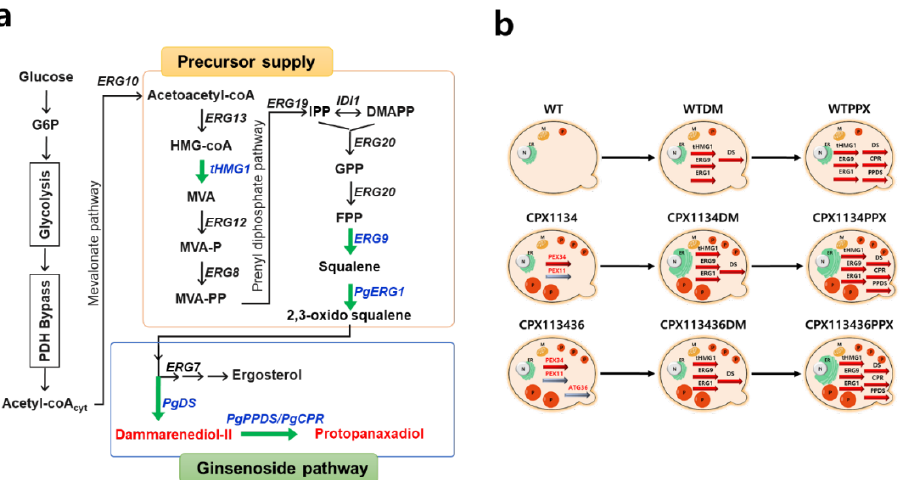
Figure 5. Production of dammarenediol II and protopanaxadiol via the mevalonate (MVA) pathway and schematic representation of the synthetic pathways in the engineered strains used in this study. ( a ) The black letters represent homogeneous enzymes, blue letters represent synthetic expression modules, and red letters represent target materials used in this study. The black arrows represent homogeneous pathway and green arrows represent heterogeneous pathways. The gene symbols and enzymes encoded by the genes (all heterogeneous genes of ginsenoside synthesis pathway were isolated from Panax ginseng , except where mentioned otherwise): ERG13, HMG-CoA synthase; tHGM1, truncated HMG-CoA reductase from Saccharomyces cerevisiae ; ERG12, mevalonate kinase; ERG8, phosphomevalonate kinase; ERG19, mevalonate pyrophosphate decarboxylase; IDI1, IPP isomerase; ERG20, farnesyl pyrophosphate synthase; ERG9, squalene synthase from S.cerevisiae ; PgERG1, squalene monooxygenase from P. ginseng ; ERG7, lanosterol synthase; PgDS, dammarenediol II synthase; PgPPDS, protopanaxadiol synthase; PgCPR, cytochrome P450 reductase. Pathway intermediates: G6P, glucose-6-phosphate; HMG-CoA, 3-hydroxy-3-methylglutaryl coenzyme A; MVA, mevalonate; MVA-P, mevalonate-5-phosphate; MVA-PP, mevalonate pyrophosphate; IPP, isopentenyl pyrophosphate; DMAPP, dimethylallyl pyrophosphate; GPP, geranyl pyrophosphate; FPP, farnesyl pyrophosphate; ( b ) Reconstruction of ginsenoside biosynthetic pathway in the peroxisome-engineered strains (Table 1).